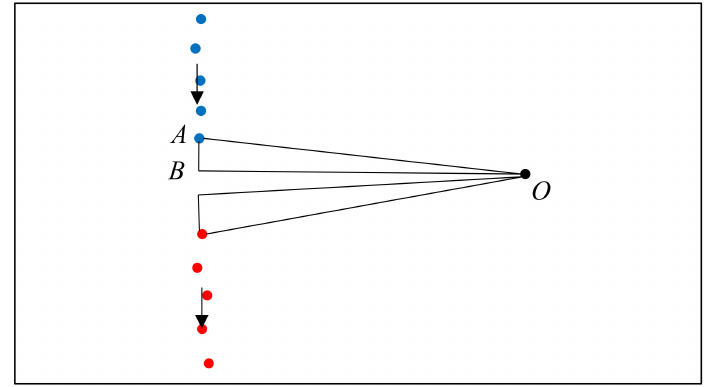
Figure 8. Example of a pair of segments (different colour represents different segment, black point: scanner